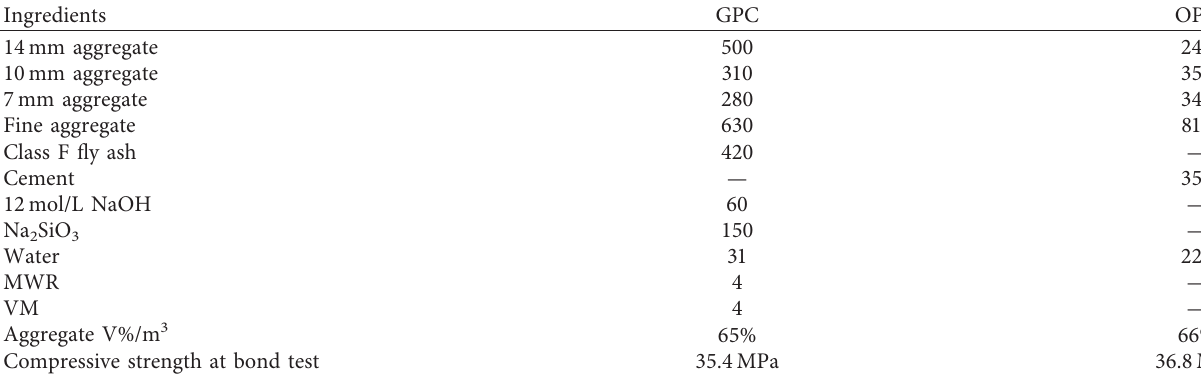
Table 2: Mix proportions of concrete (kg/m 3